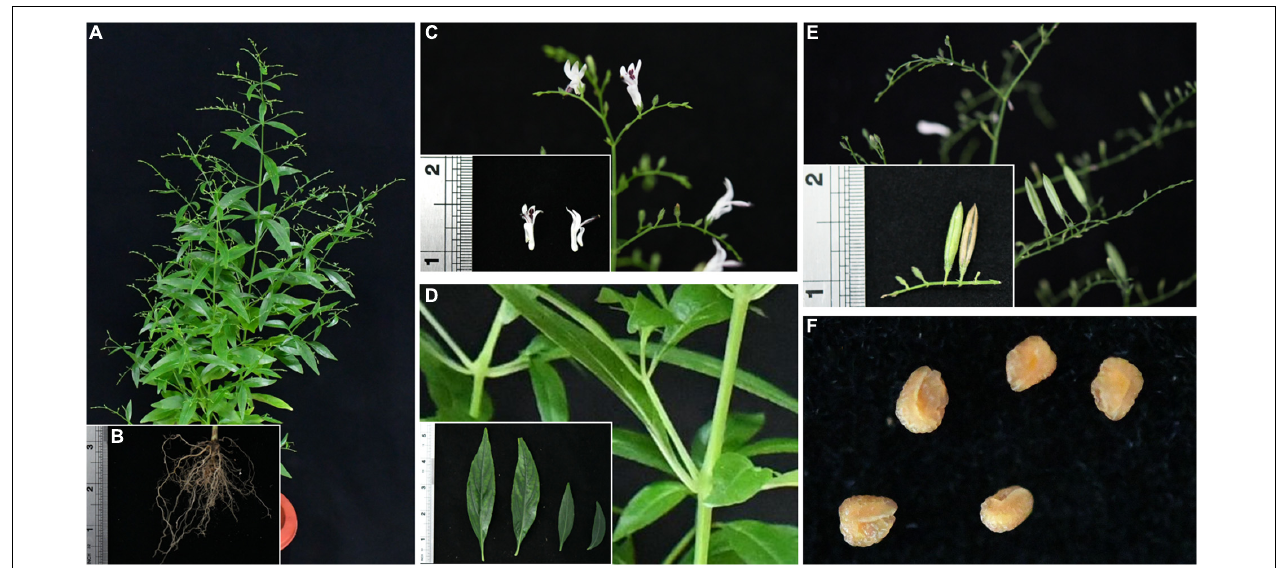
FIGURE 1 | An annual herb of Traditional Chinese medicine for clearing heat and detoxifying. (A) AP: plant, (B) roots, (C) flowers, (D) stems and leaves, (E) mature and immature fruits, and (F)